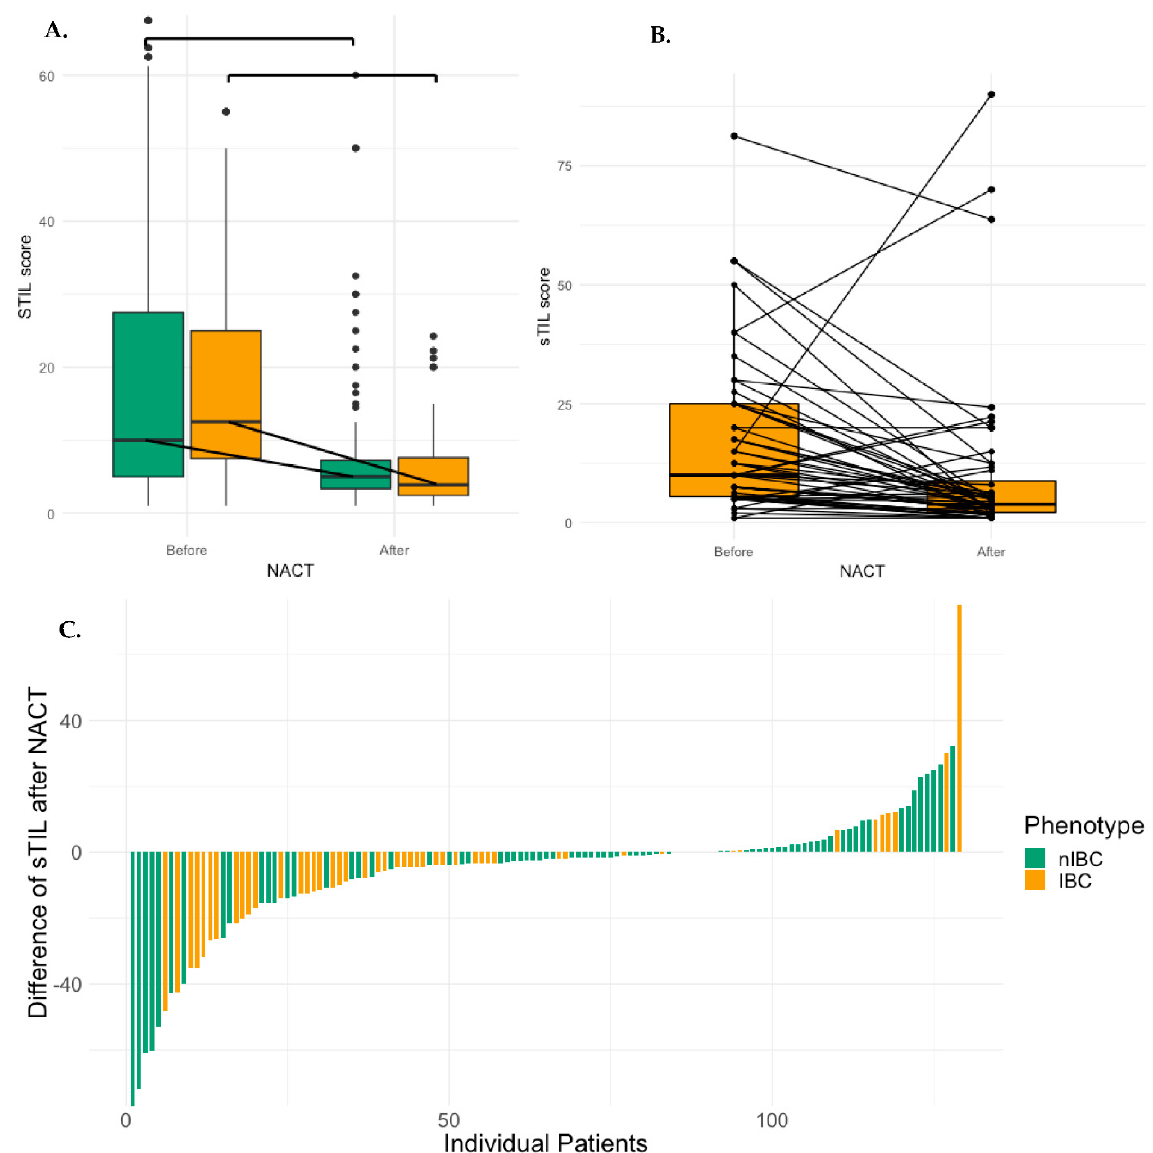
Figure 1. ( A ) Boxplot graph of the evolution of sTIL after NACT: In both IBC (median δ sTIL: − 4.5%, p < 0.001) and nIBC (median δ sTIL: − 1.25%, p = 0.06) the number of sTIL are lower after NACT ( B ) Boxplot depicting the evolution of median sTIL after NACT in individual IBC patients: Out of 50 patients, 7 had an increase, 21 had no change and 22 patients had a decrease. ( C ) Waterfall plot of sTIL difference ( δ sTIL) in all patients. IBC had more often a decrease than nIBC patients ( p = 0.044). nIBC: non-inflammatory breast cancer, IBC: inflammatory breast cancer, sTIL: stromal tumour infiltrating lymphocytes, NACT: neo-adjuvant chemotherapy. Table 4. Uni- and multivariate analysis for decrease of sTIL after NACT (< − 2.5%). nIBC: non-inflammatory breast cancer, IBC: inflammatory breast cancer, HR: hormone receptor status, sTIL: stromal tumour infiltrating lymphocytes, NACT: neo-adjuvant chemotherapy. RD: residual disease, NLR: neutrophil-lymphocyte ratio, PLR: platelet-lymphocyte ratio, LMR: lymphocyte-monocyte ratio and, sTIL: stromal tumour infiltrating lymphocytes, NACT: neo-adjuvant chemother- apy. Bold values denote statistical significance at the p < 0.05 level.